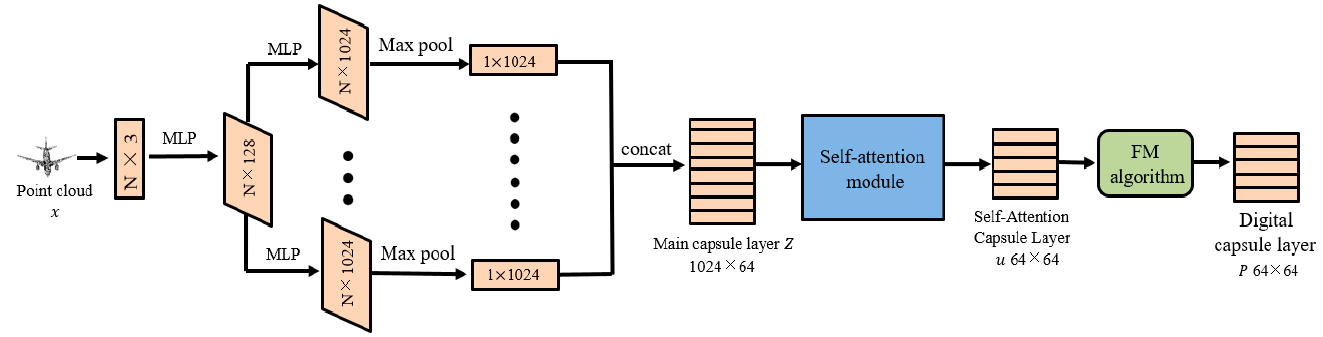
Figure 3. Self-attention point cloud capsule network.